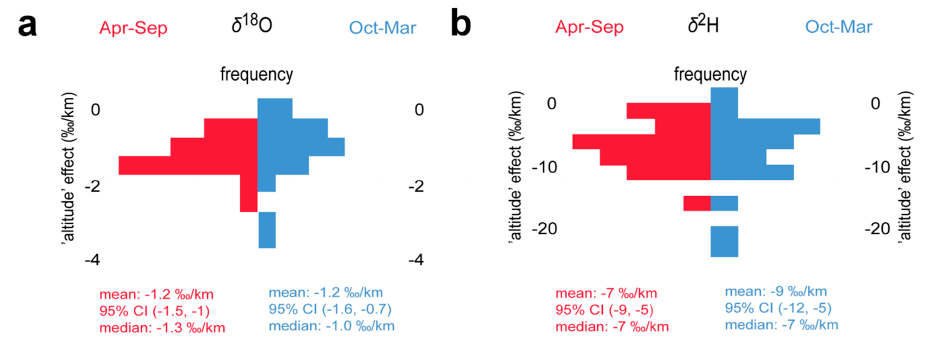
Figure 3. Frequency distribution of ‘altitude’ effects estimated from monthly precipitation δ 18 O ( a ) and δ 2 H ( b ) data for colder (October to March) and warmer (April to September) seasons.